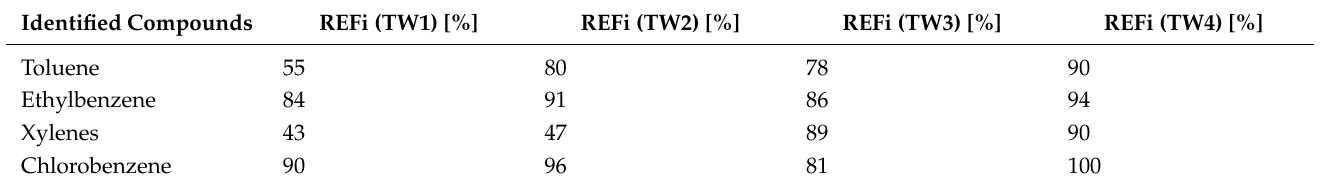
Table 3. Removal efficiency factors (REFi) for the identified VOCs for studied water treatment technology procedures